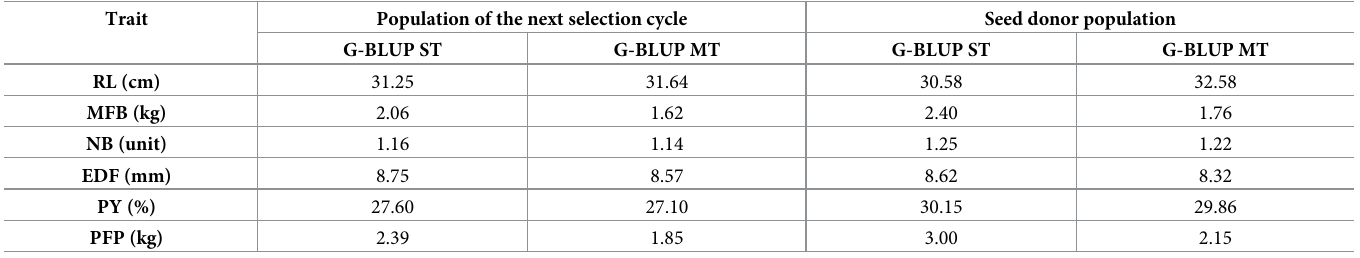
Table 4. Estimates of selection gains provided by the G-BLUP ST and G-BLUP MT models. Estimates of selection gains provided by the single-trait (G-BLUP ST) and multi-trait (G-BLUP MT) models for the selected genotypes (S.I.) for the population of the next selection cycle (50 genotypes), and the commercial seed donor population (six